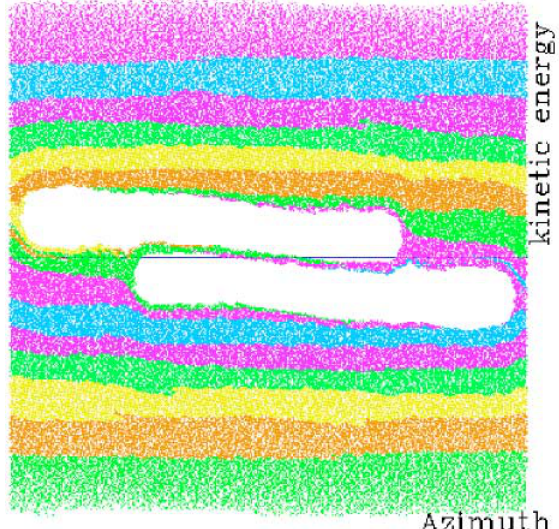
FIG. 29. (Color) Scatter plot at 2 13.8 ms, 2.5 3 10 12